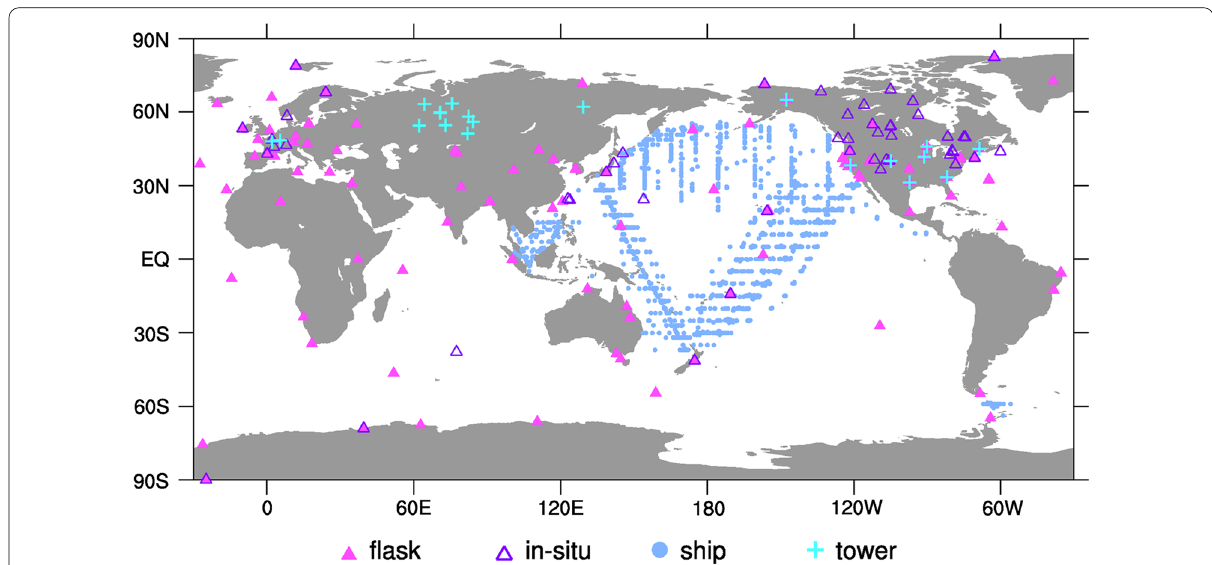
Fig. 3 Locations of observations used in the pseudo-observation inversion experiment. The observations are the same as those of NISMON-CO 2 v2021.1 (Niwa 2020) but for those available during 2007–2018. Flask air sampling and in situ observations at ground-based stations are depicted by filled magenta and unfilled purple triangles, respectively. Light blue circles denote shipboard observational locations. Tower observation sites are denoted by cyan